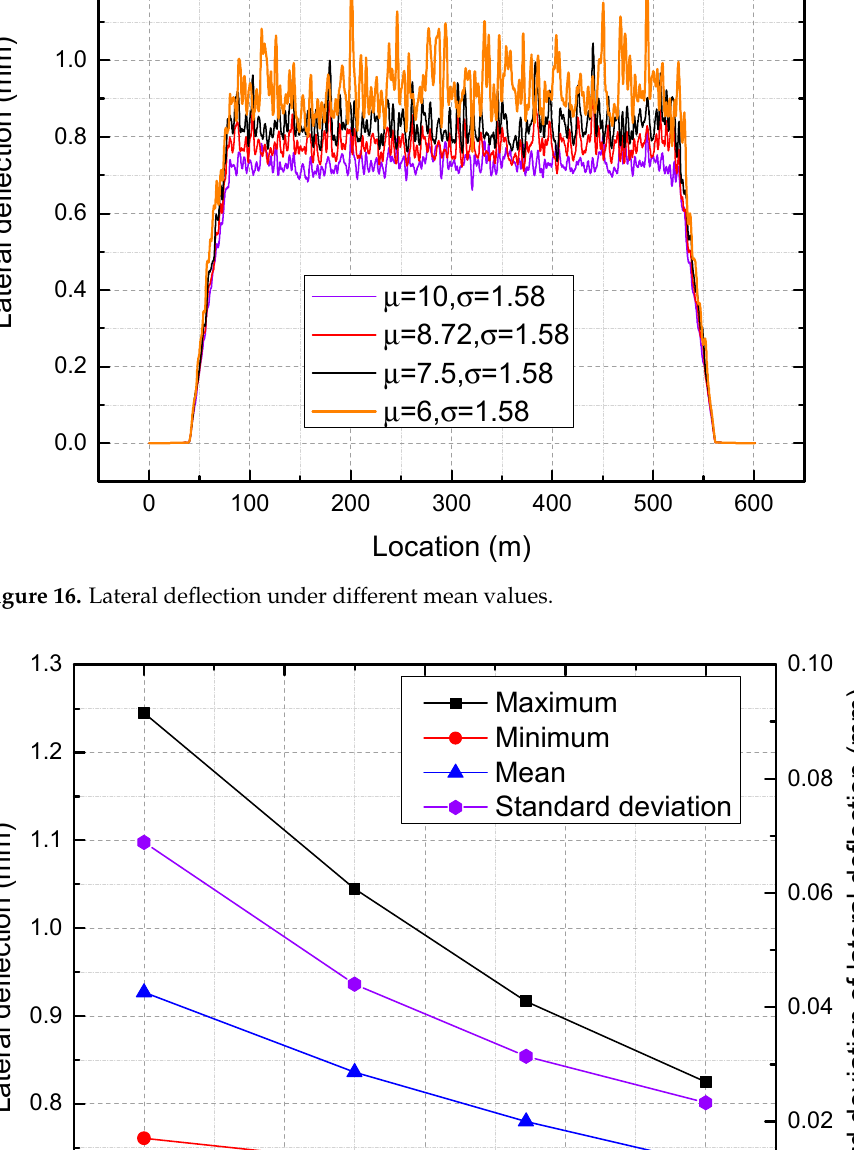
Figure 18. Lateral de fl ection under di ff erent standard deviations. The maximum, minimum, mean, and standard deviations of lateral de fl ection are presented versus the standard deviation of input lateral ballast resistance in Figure 19.